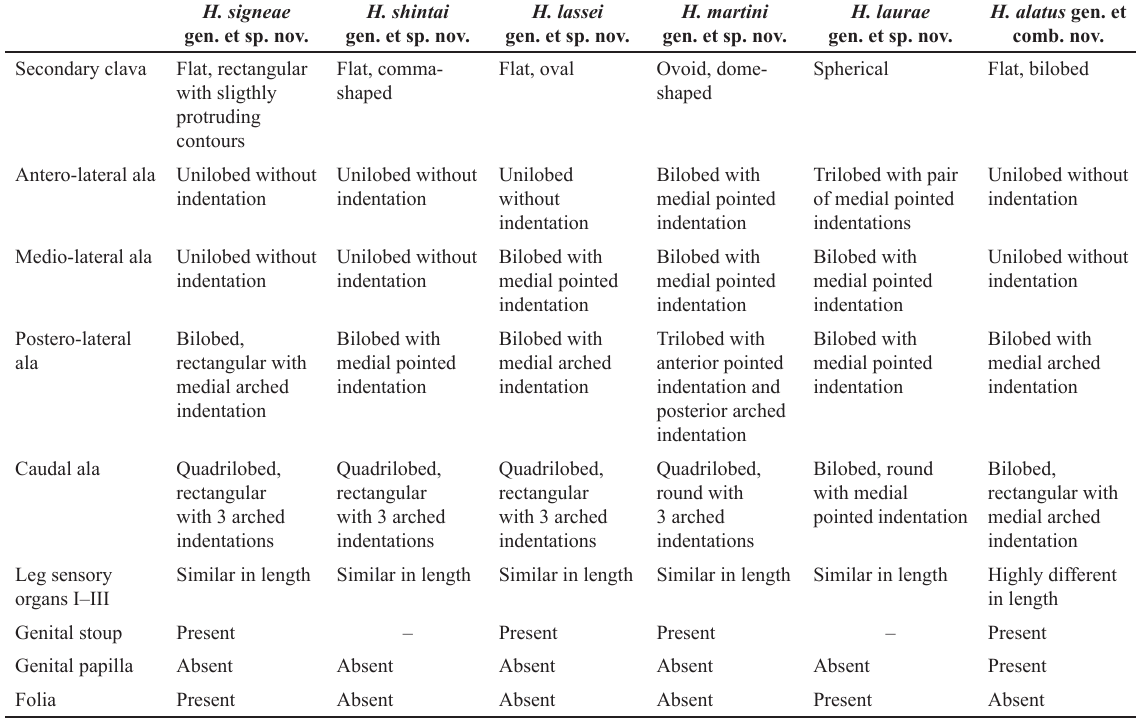
Table 1. Differential table of major morphological characters in species of Higginsarctus gen. nov.